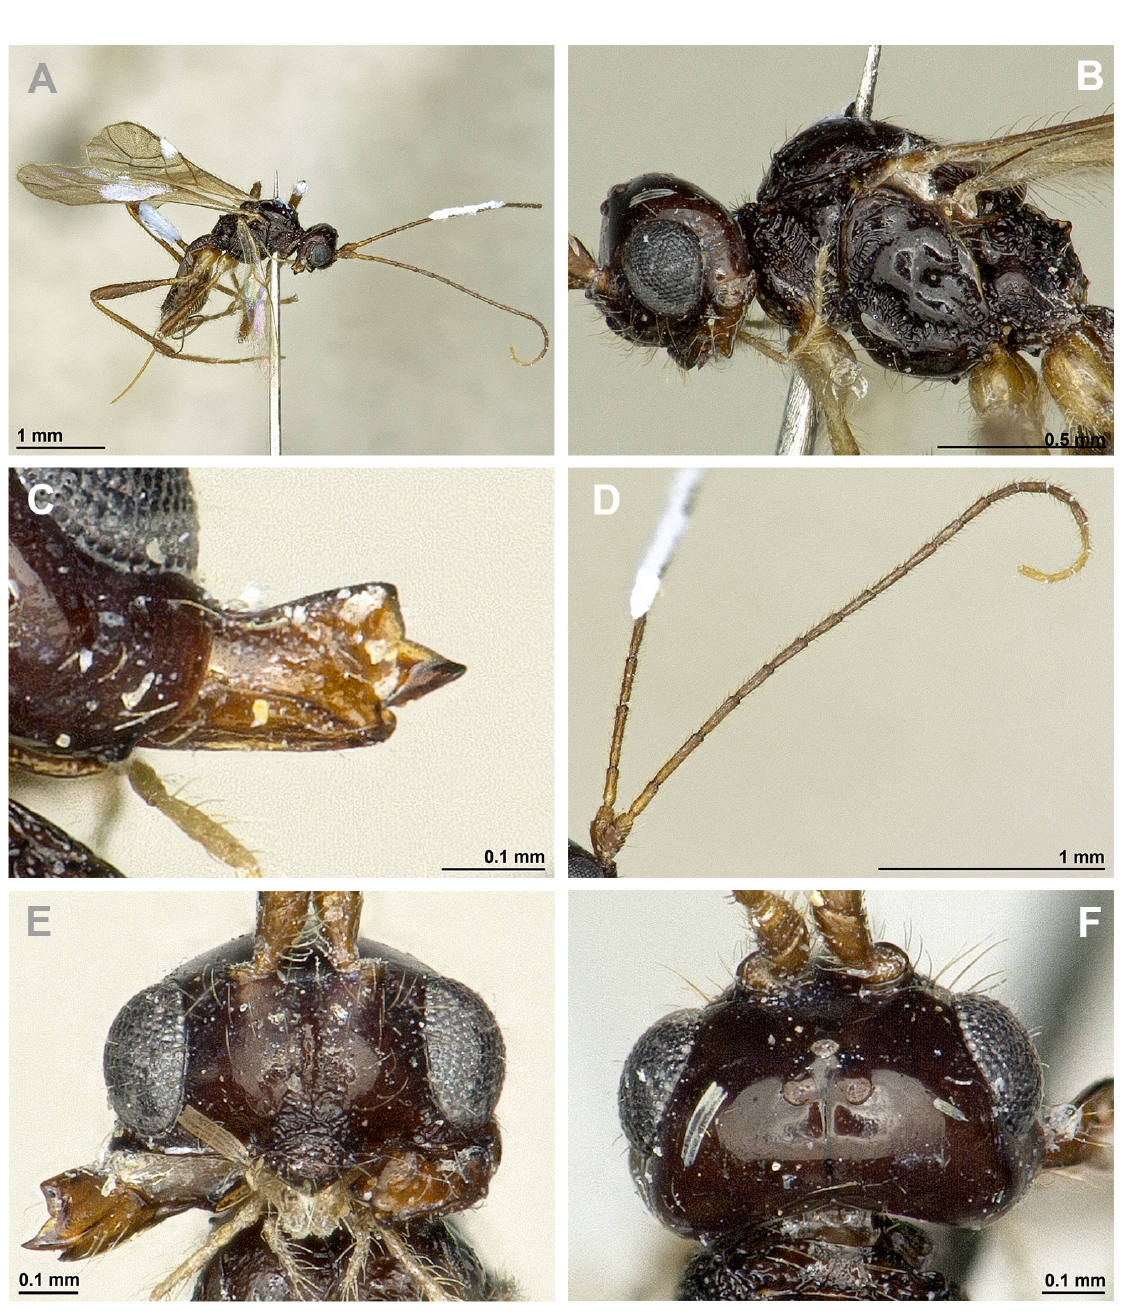
Fig. 13. Asobara elongitarsis van Achterberg, sp. nov., ♀, holotype (RMNH 8234). A . Habitus, lateral view. B . Head and mesosoma, lateral view. C . Mandible. D . Antenna. E . Head, front view. F . Head, dorsal